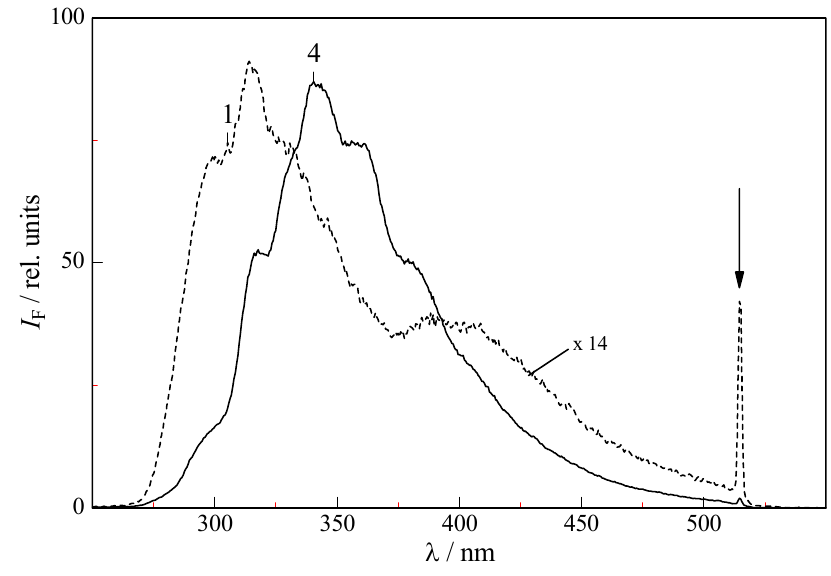
Figure 3. LIF spectra of neat oil product 1 and 4 ( λ of the fluorescence onsets might be influenced by the cut-off